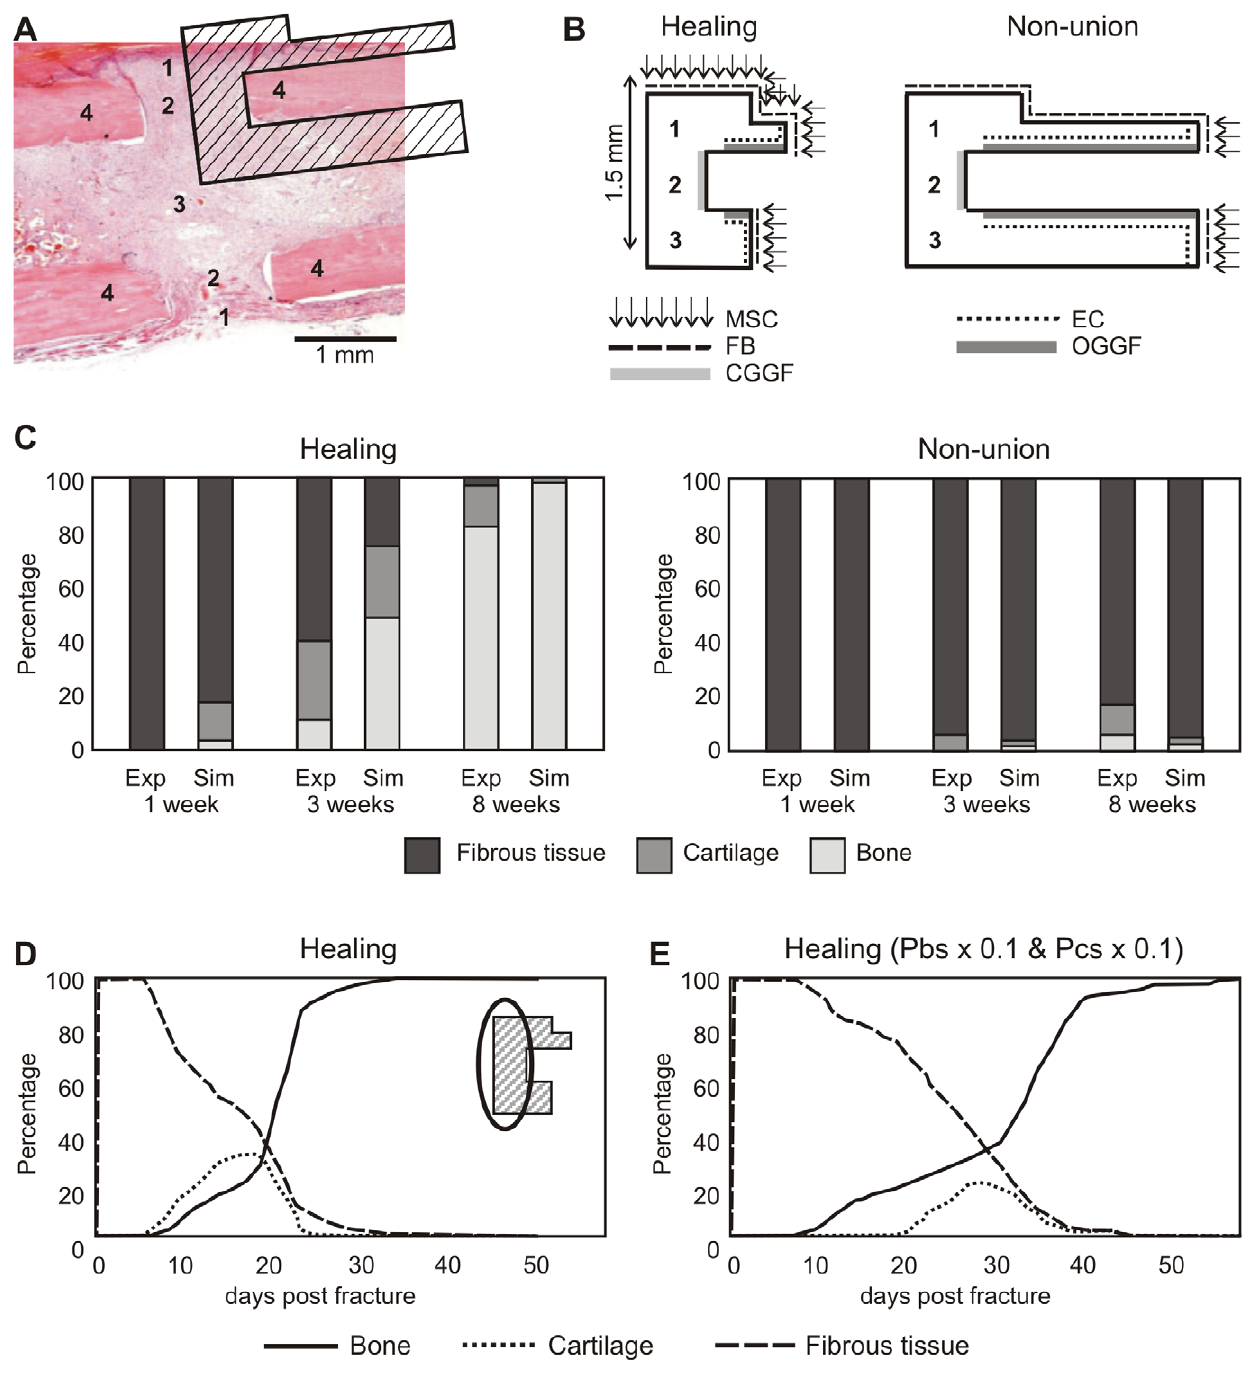
Figure 2. Mathematical modelling of the regeneration process in healing and non-union groups. ( A ) Domain of the simulations. 1: periosteal callus; 2: intercortical gap; 3: endosteal callus; 4: cortical bone. ( B ) Boundary conditions for healing and non-union model. MSC: mesenchymal stem cells; FB: fibroblast; OB: osteoblast; EC: endothelial cell; CGGF: chondrogenic growth factor; OGGF: osteogenic growth factor. ( C ) A comparison of experimentally measured (Exp) [7] and numerically calculated (Sim) tissue constituents present within the interfragmentary gap of healing and non-union groups (stacked bars). ( D ) Temporal evolution of the numerically calculated tissue fraction for the healing group. The insert shows the interfragmentary region of the simulation domain. ( E ) Temporal evolution of the numerically calculated tissue fraction for the healing group with reduced (by factor 10) cartilage (P cs ) and bone matrix (P bs ) production rates leading to a better correspondence between experimental and simulation results.